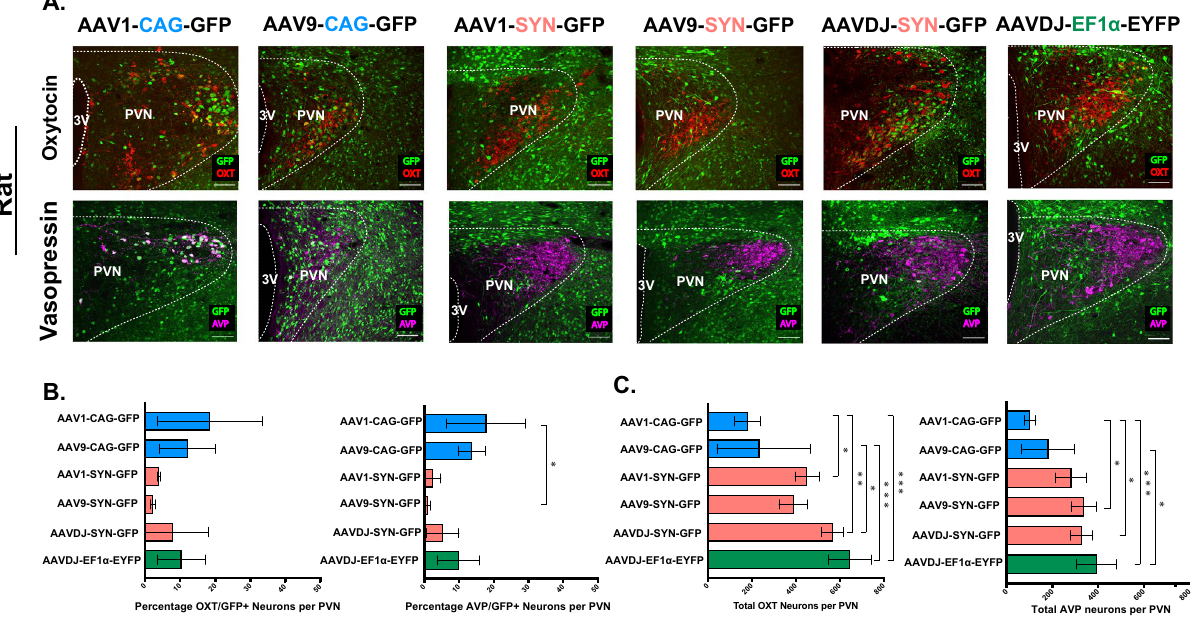
Figure 1. Transduction efficiency of different combinations of adeno-associated viral (AAV) serotypes and promoters in oxytocin (OXT) and arginine-vasopressin (AVP) neurons of the hypothalamic paraventricular nucleus (PVN) of adult rats. ( A ) Confocal images of rat brain tissues, three weeks following viral injection in the PVN and immunostaining with anti-OXT (red, top panel) or anti-AVP (magenta, bottom panel). GFP is encoded by the virus (green, top and bottom panels). 20×, Scale bar = 100 μm, dotted line demarcates the PVN and the 3rd ventricle; 3 V. ( B ) Bar graphs (± SEM) show the average percentage of OXT positive (OXT+, left) or AVP positive (AVP+, right) neurons that also express the virus (GFP+) in the PVN. Low percentages, reflecting low transduction efficiency, were observed across all viruses in both OXT and AVP neurons, with the highest efficiency observed when using AAV serotypes (AAV1 or AAV9) in combination of the CAG promoter. ( C ) Bar graphs (± SEM) show the total number of OXT (left) or AVP (right) neurons per rat PVN. n = 3–4 rats per virus with an average of 10 slices per rat PVN. *p < 0.05, **p < 0.005, ***p < 0.0005.